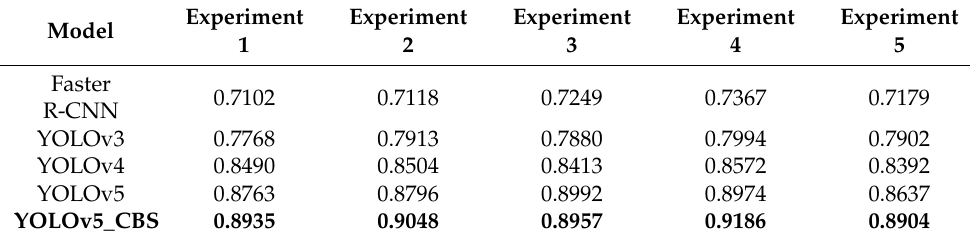
Table 6. F1 score of compared models on FLOW-Img public dataset.